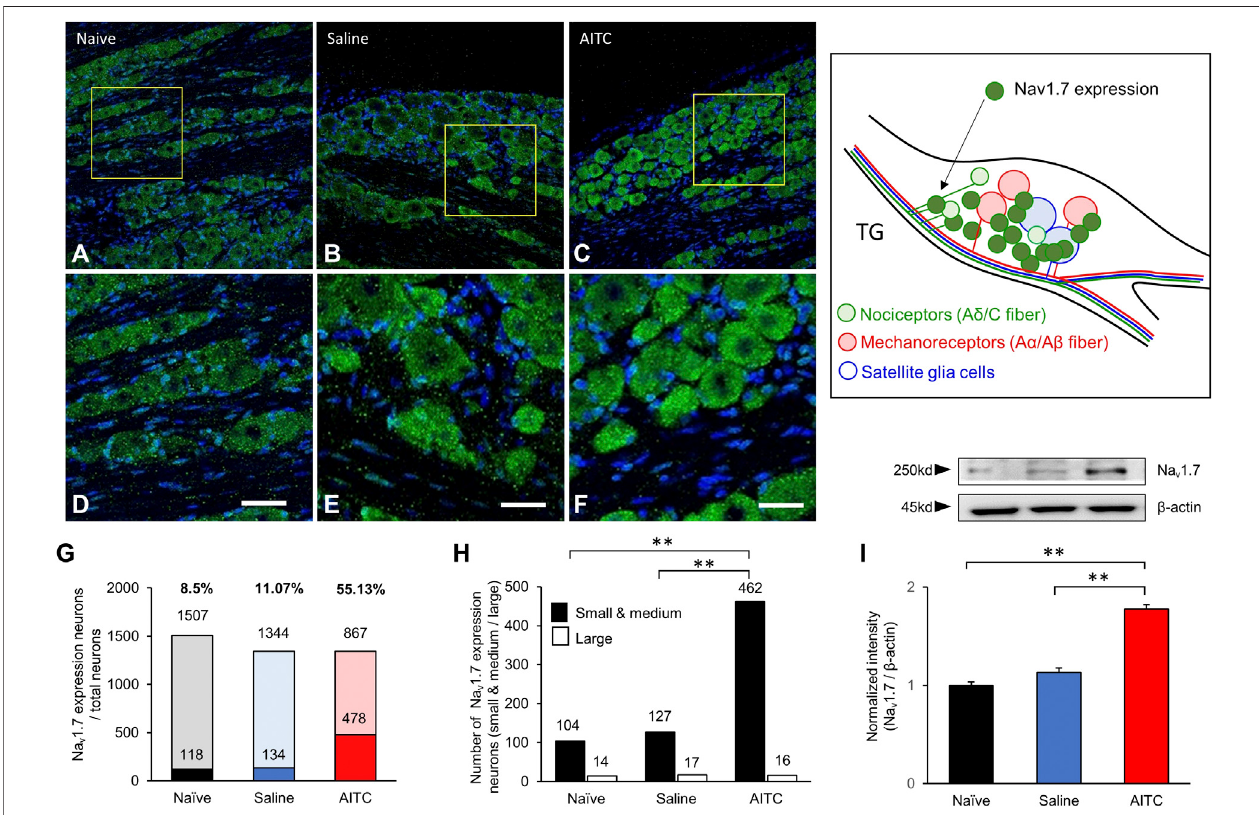
FIGURE3| ExpressionsofNav1.7intheTG. (A – C) ImmunostainingshowingNav1.7expressionintheTG.TheproteinexpressionofNav1.7increasedintheTGin AITC-treated group. (D – F) Figures present enlarged yellow squares in a, b, and c, respectively. (G,H) The expression ratios were presented and the size-dependent Nav1.7 expression neurons were counted. The highest level of nav1.7 expression was observed in AITC-treated groups. (I) Expressions of Nav1.7 were analyzed using western blot (Scale bar (cid:1) 20 µm, Error bars represent SEM; ** p < 0.01, n (cid:1) 4 each).